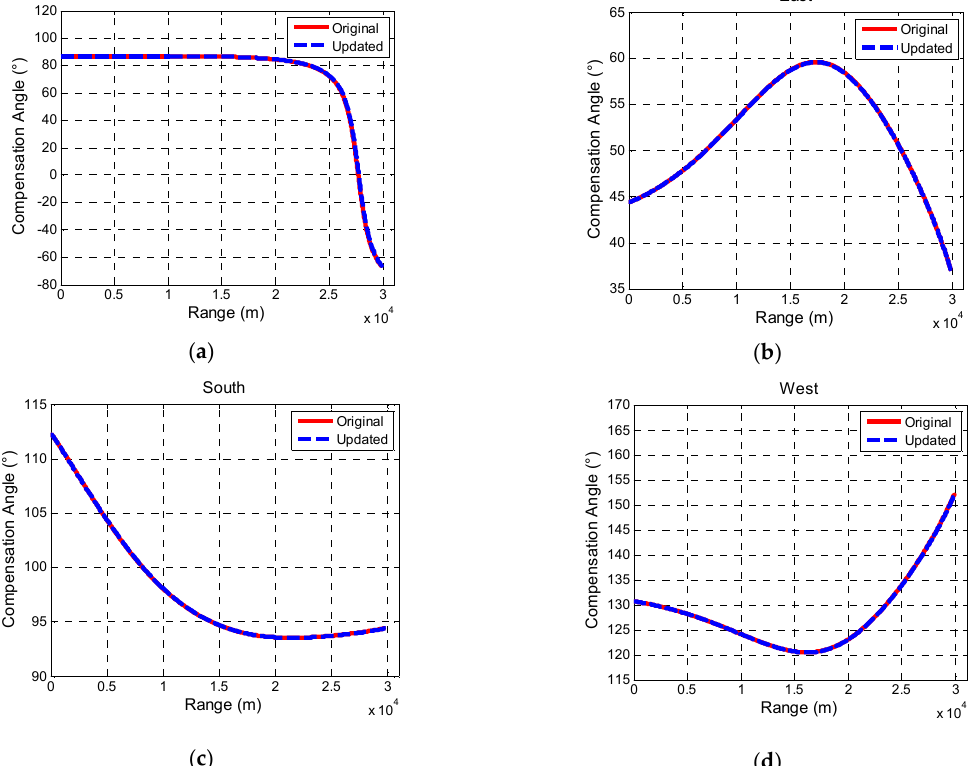
Figure 14. Comparison of compensation angle based on different geomagnetic information in north direction ( a ), east ( b ) direction, south ( c ) direction, and west ( d ) direction. Analysis of deviation of compensation angle caused by different geomagnetic information is shown as